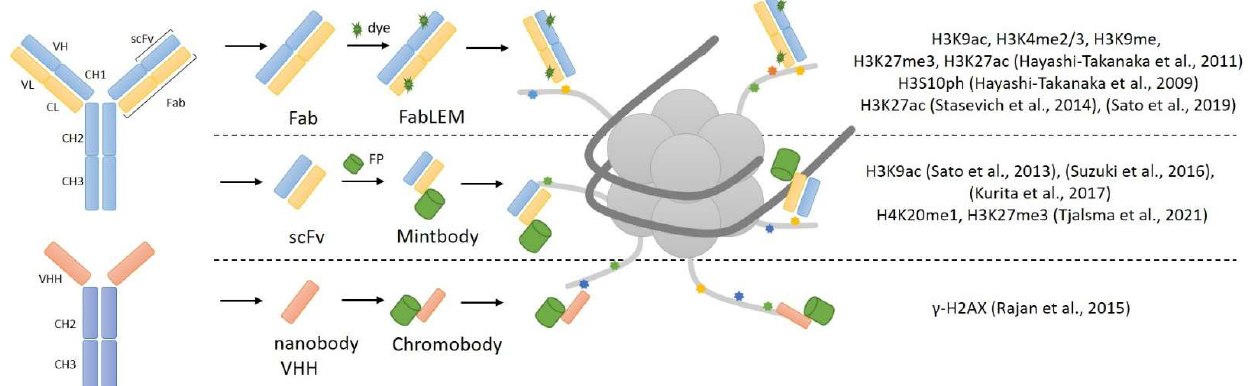
Figure 2. Schematic representation of the antibody-derived probes for histone modification imaging [16–24,26].